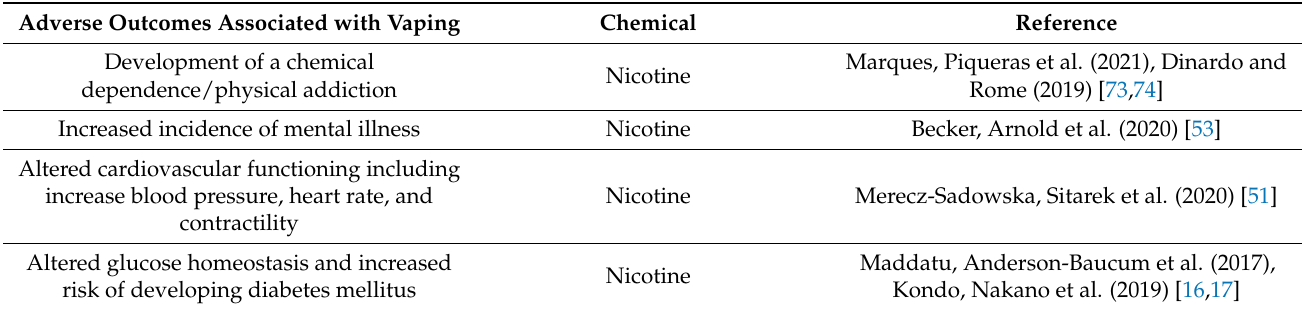
Table 2. Health effects associated with e-cigarette use